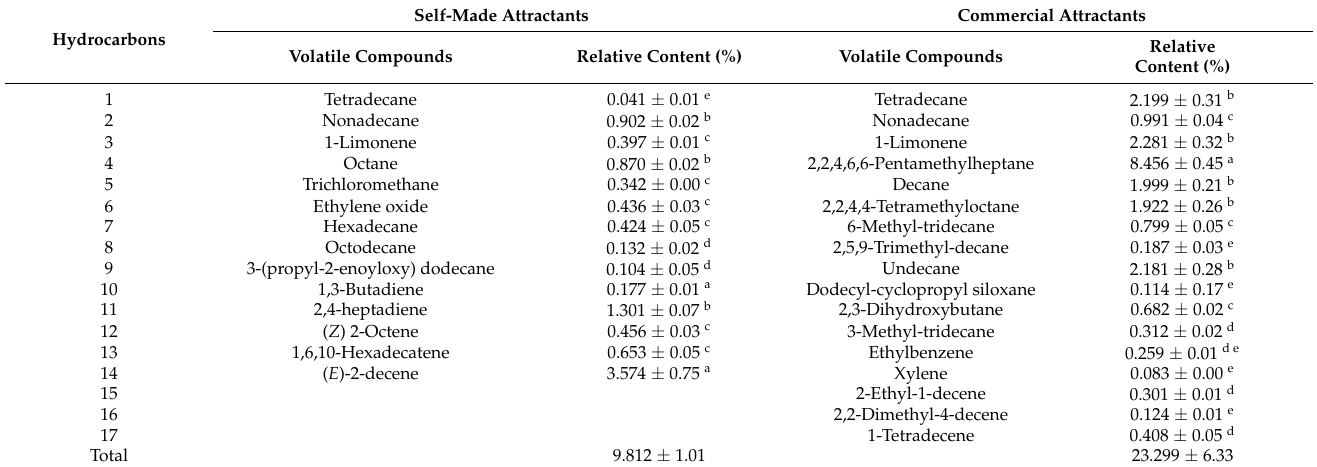
Table 2. Hydrocarbons in self-made and commercial attractants (percentage of the total peak area).